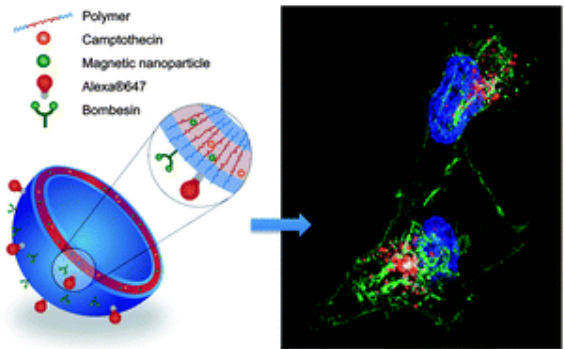
Figure 20. Scheme of loaded magnetic polymersomes prepared from a PEO–PPO–PEO copolymer where the hydrophobic cargo (be it a magnetic nanoparticle or drug molecule) was implemented into the PPO liposome section. Reprinted with permission from ref. [24]. Copyright 2022, Royal Society of Chemistry.